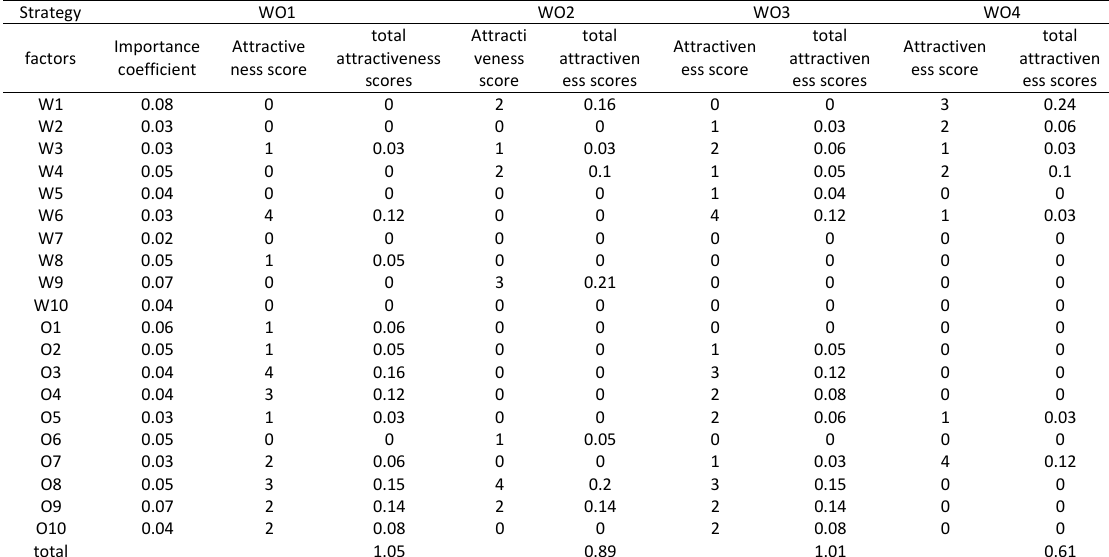
Table 6. QSPM of WO strategies